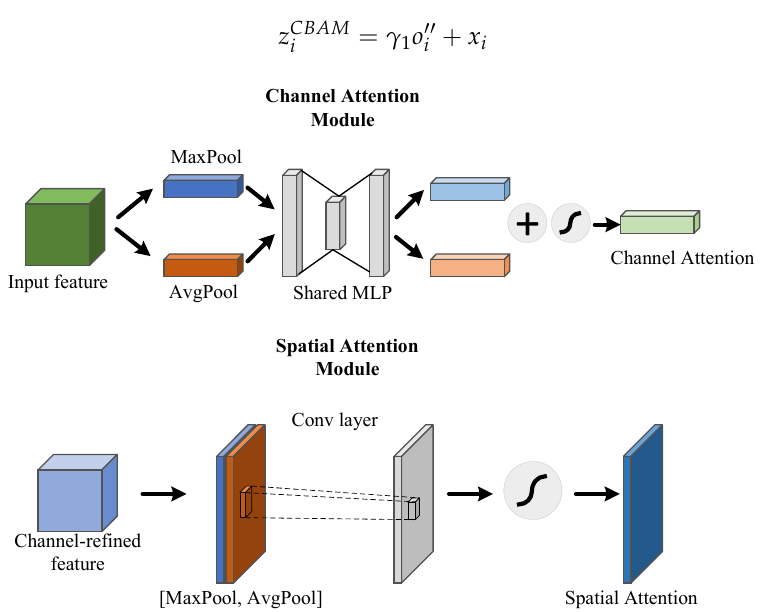
Figure 3. Diagram of the channel attention module and spatial attention module for the Convolutional Block Attention Module